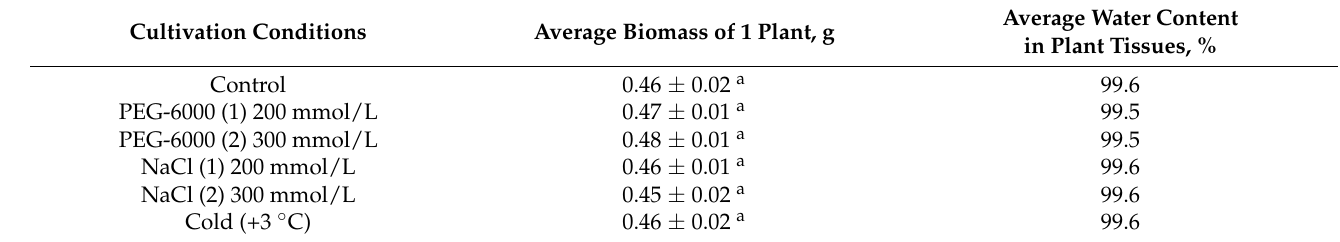
Table 1. Plant biomass and water content in plant tissues, biomass accumulation and water content in plant tissues in S. hybridum plants under control and stressful conditions. Same letters “ a ” above numerical values represent no significant differences at p ≤ 0.05. Values are means ± SE, n = 12. Average Water Content Cultivation Conditions Average Biomass of 1 Plant, g in Plant Tissues,